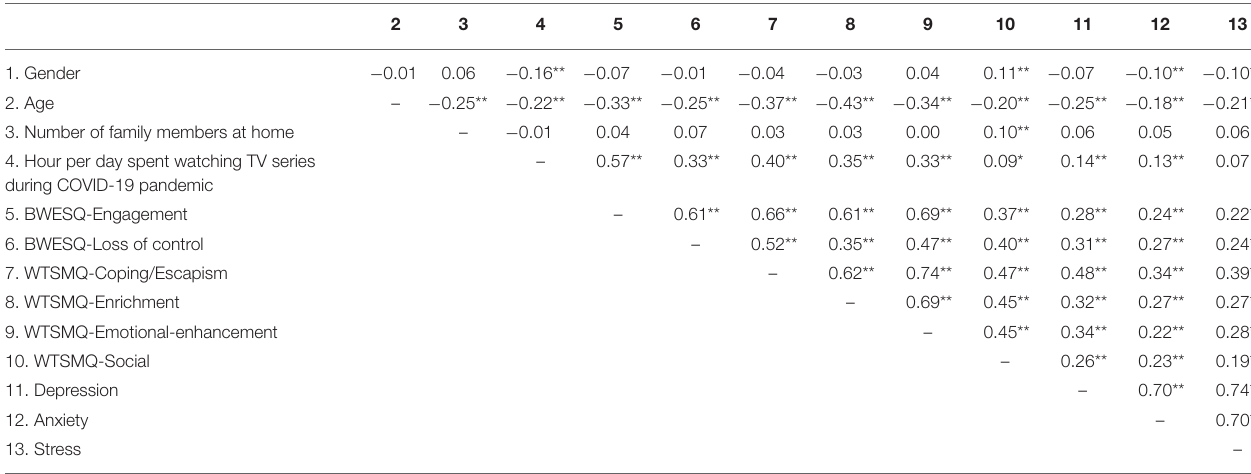
TABLE 2 | Pearson’s r correlations between the